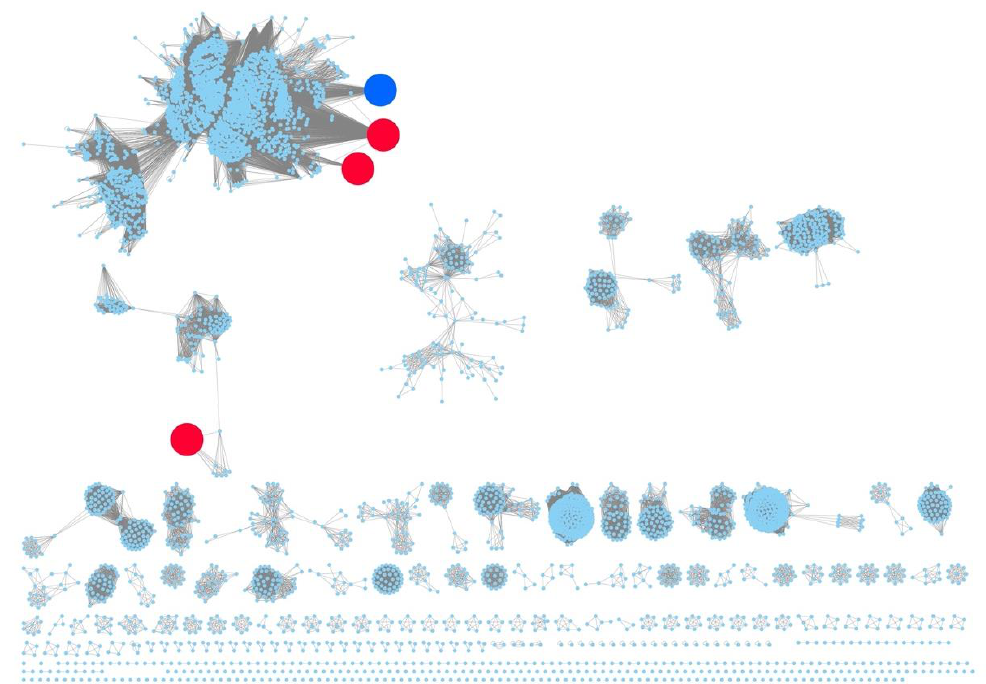
Figure 1. Full SSN of BBEs (IPR012951). The three orthologues capable of catalyzing the production of cannabinoids are denoted by the red circles. Q8GTB6 is denoted by the blue circle. Image generated using Cytoscape [11].